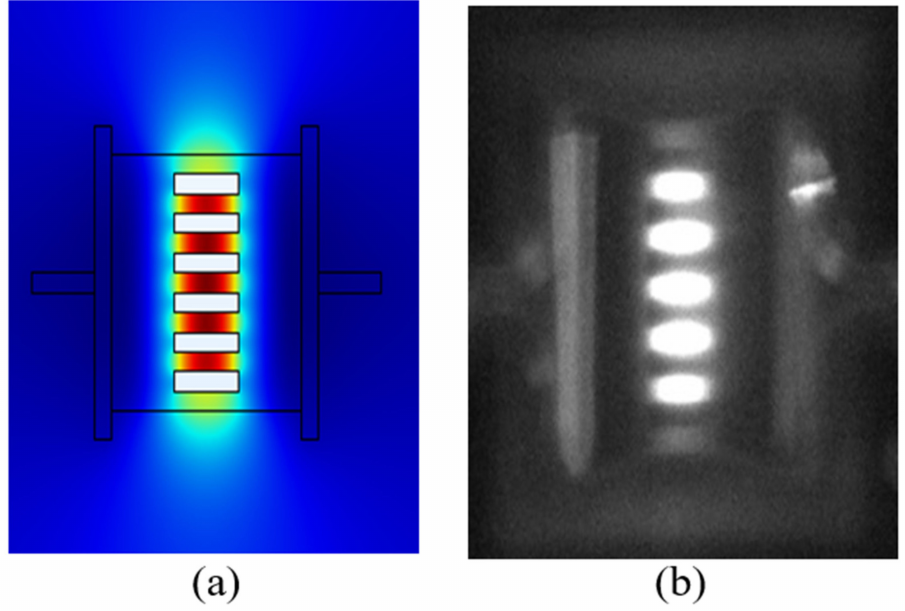
Figure 2. ( a ) Modelled Micro Hotplate showing solid contours for temperature of the microheater with PolySi layer built on a Si3N4 substrate ( b ) IR-camera image of the actual Micro Hotplate.